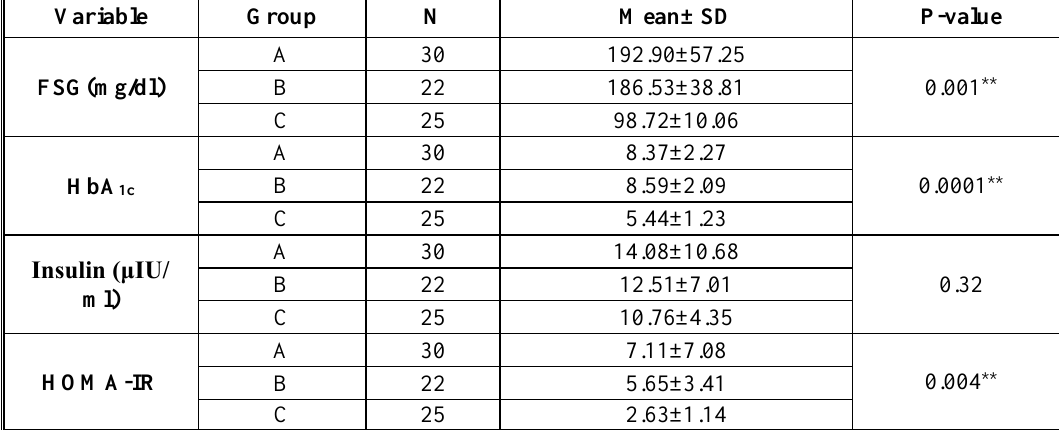
Table 2. Descriptive statistics of glycemic parameters and significant comparative studies between studied